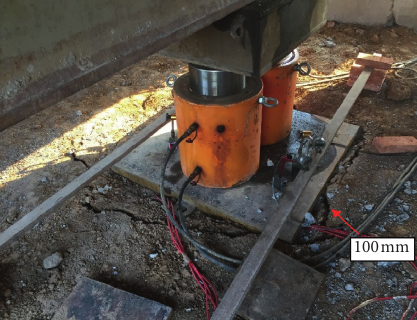
Figure 8: Punching failure of pile.